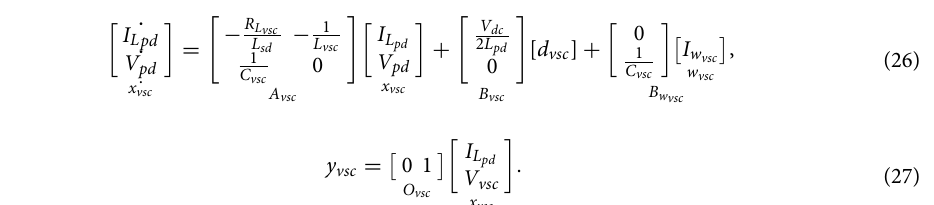
Figure 6. The VSI controller block